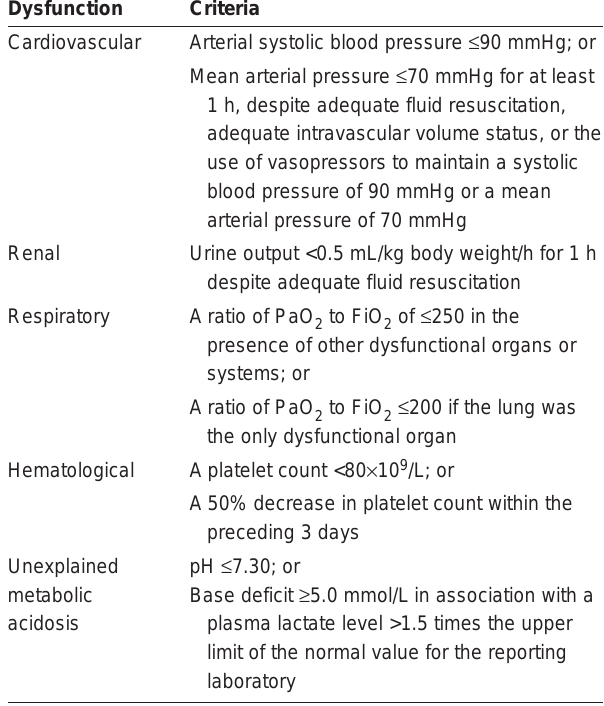
TABLE 4 Criteria for organ dysfunction in the PROWESS trial* Dysfunction